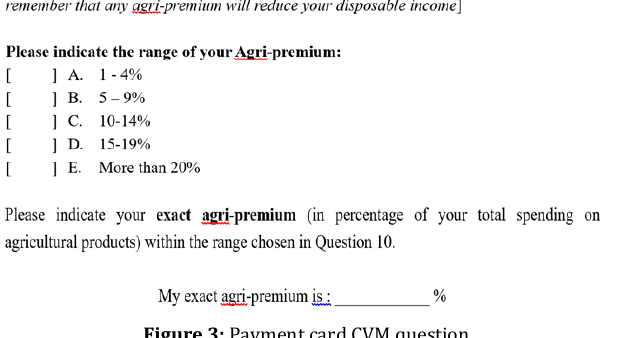
Figure 3: Payment card CVM